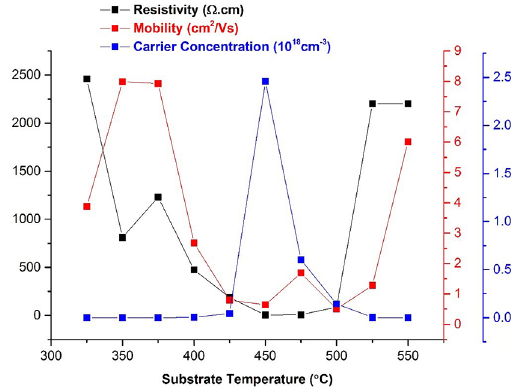
A sharp cut-off was observed in ultraviolet region at around 380 nm that is due to band edge absorption of ZnO in this area, the monodispersed nature 51 , and an almost uniform size of nanoparticles 52 which is also observed by Look 53 and Zhang et al. 54 at 373 nm and 369 nm, respectively. Fig. 9 demonstrates the optical transmittance spectra resulting from ZnO thin films covered by a few angstroms of Ag with different thicknesses. Ag has a very high reflectance. Therefore, for ZnO/Ag bilayers, as the thickness of Ag is increased, transmittance is